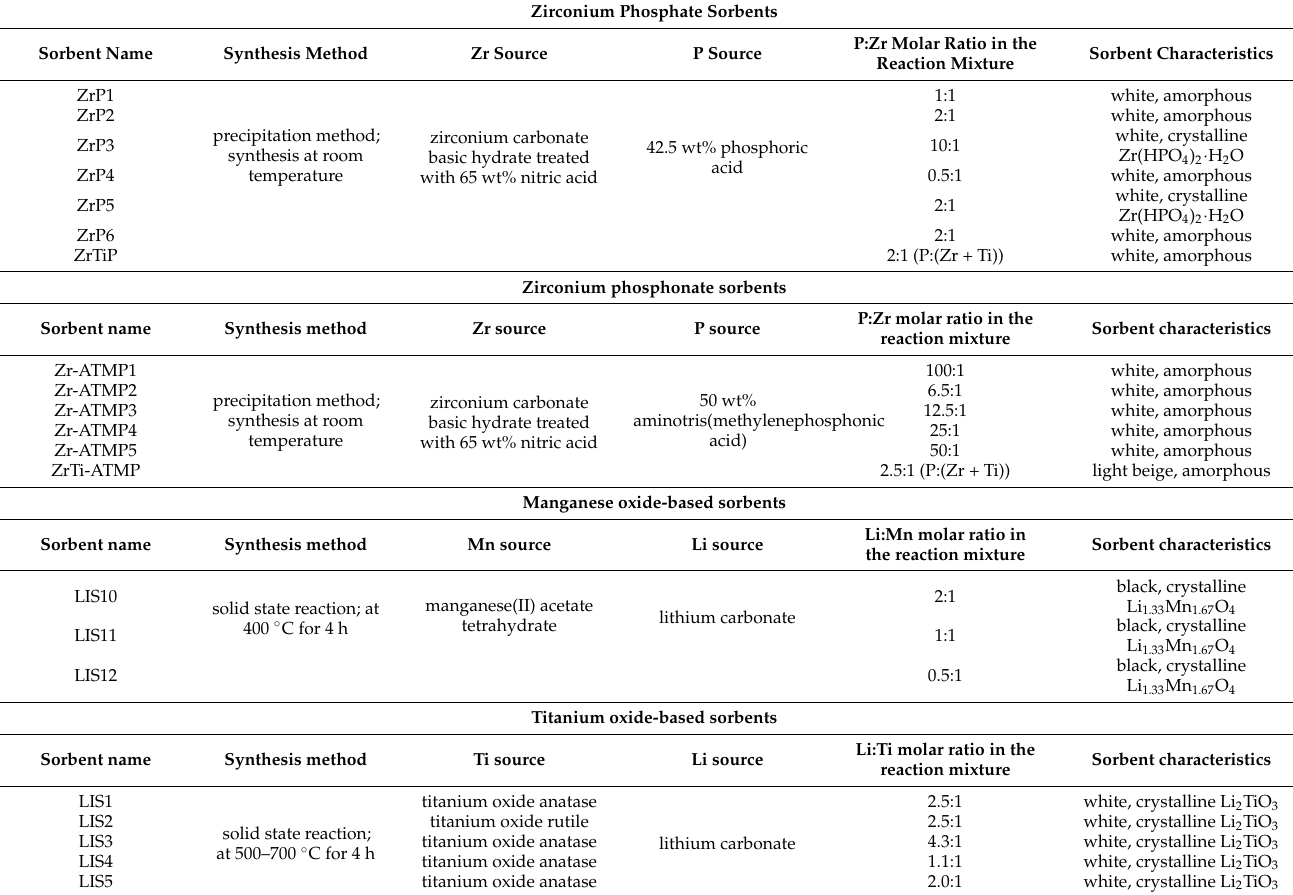
Table A1. Data on the synthesis and characteristics of the obtained